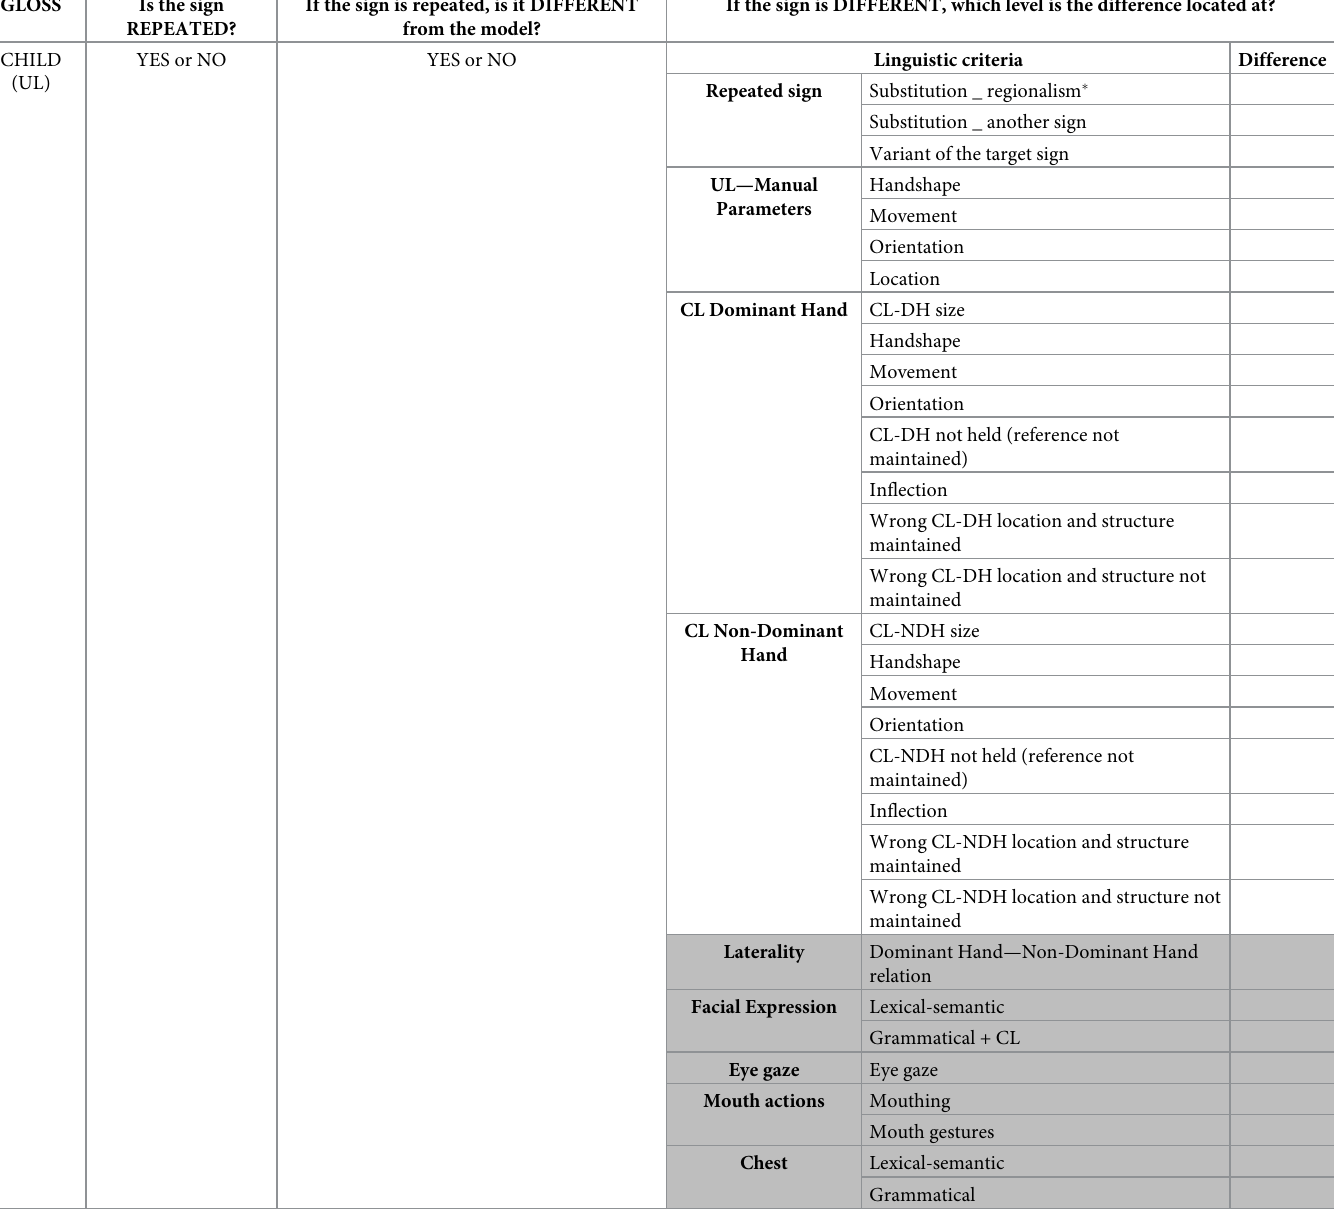
Table 2. Scoring grid for all